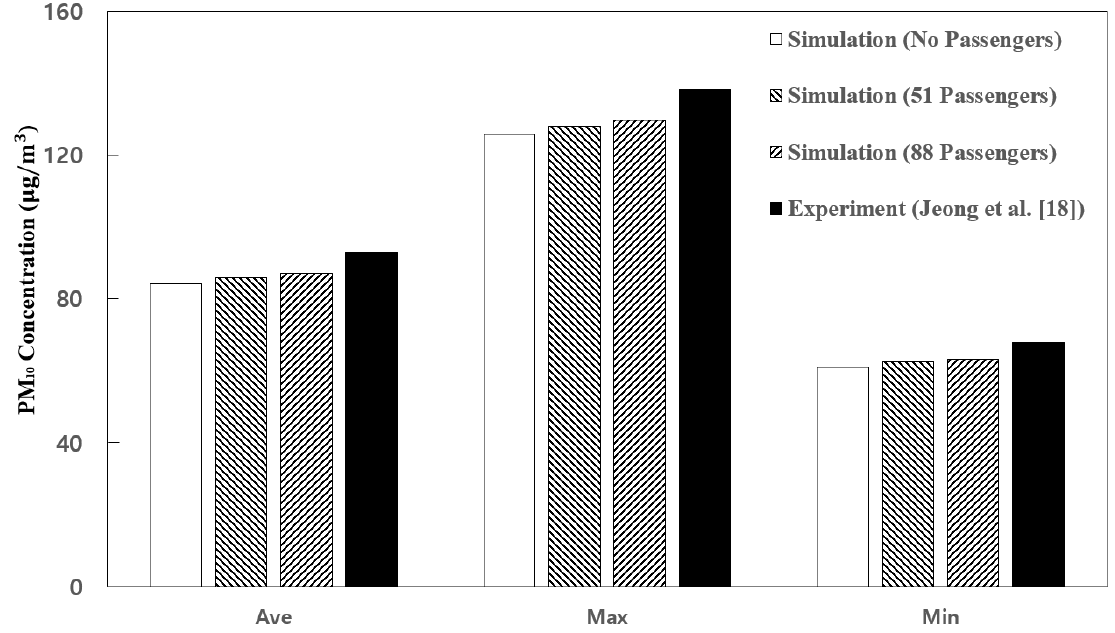
Figure 4. Comparison of the PM 10 concentration at the measurement point inside the subway cabin between the simulation prediction results of this study and the measurement data obtained by Jeong et al. [18].